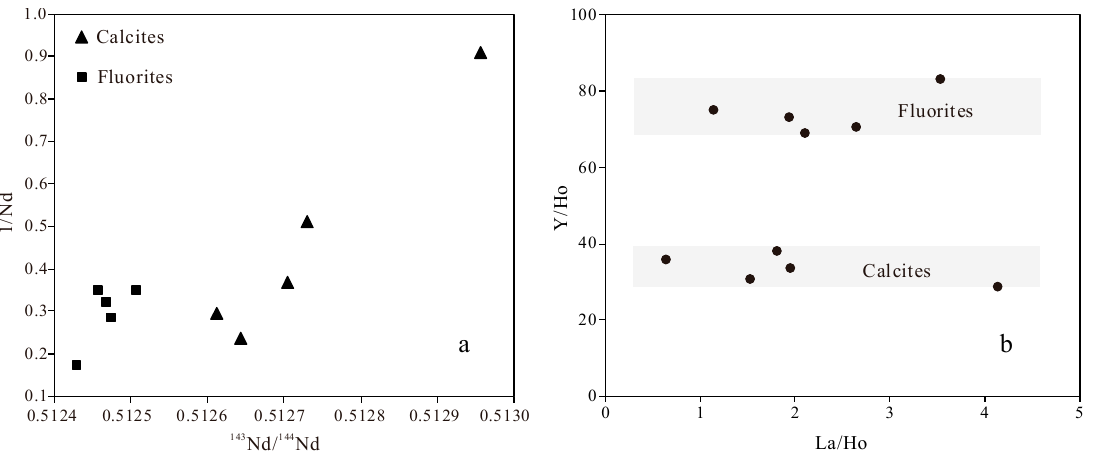
Figure 6. Diagrams of 1/Nd vs. 143 Nd/ 144 Nd ( a ) and Y/Ho vs. La/Ho ( b ) for the calcite and fluorite.